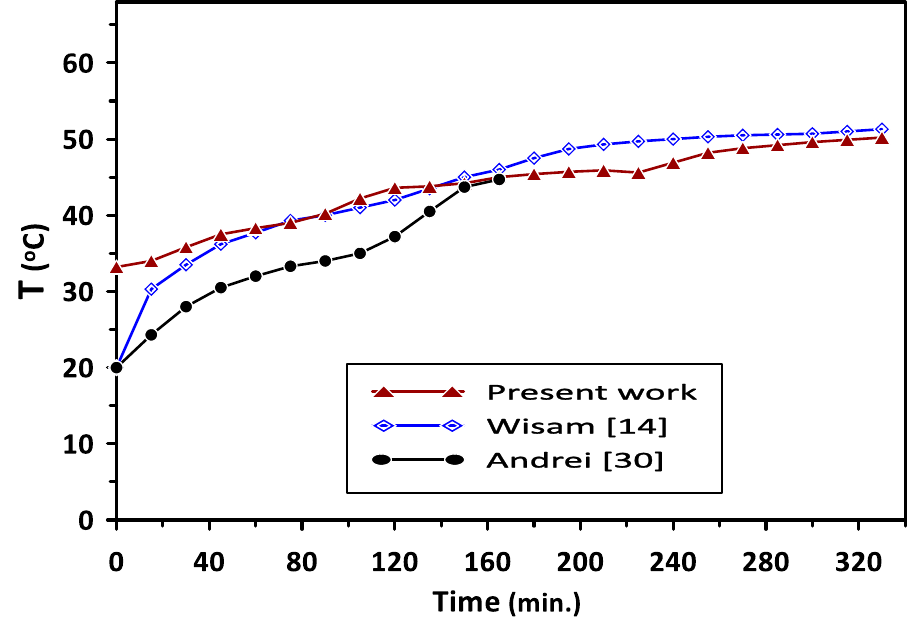
Figure 12. Comparison of the present work’s results of the PCM2 temperature distribution during the melting process with the previous investigations.